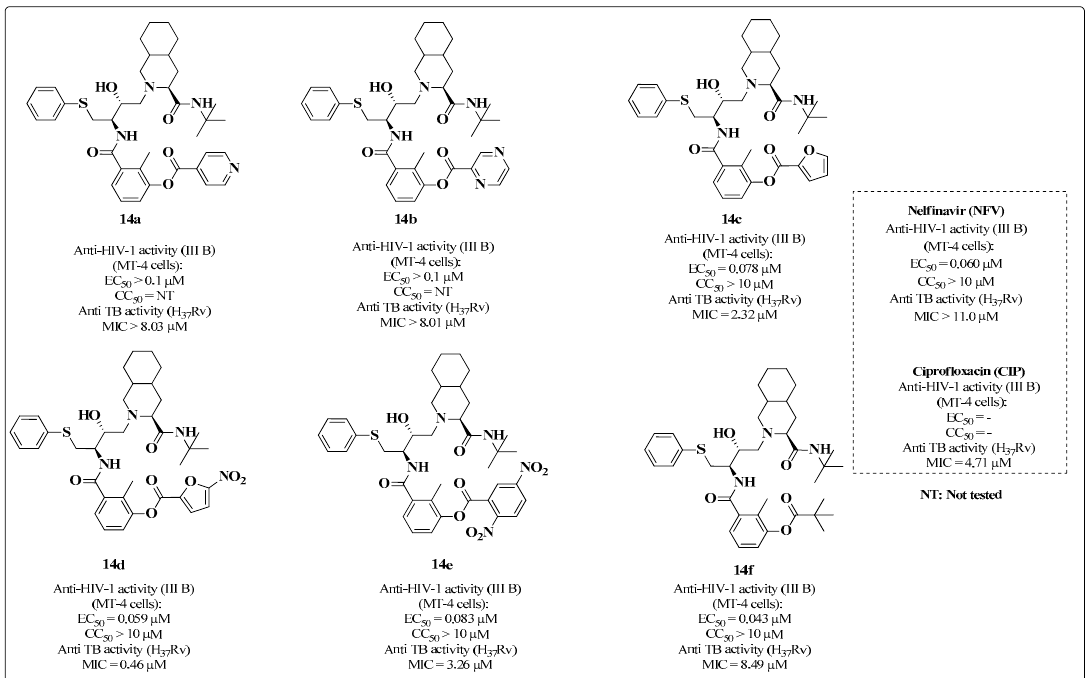
Figure 13. Anti-HIV and anti-MTB activities of NFV-derived compounds [92].